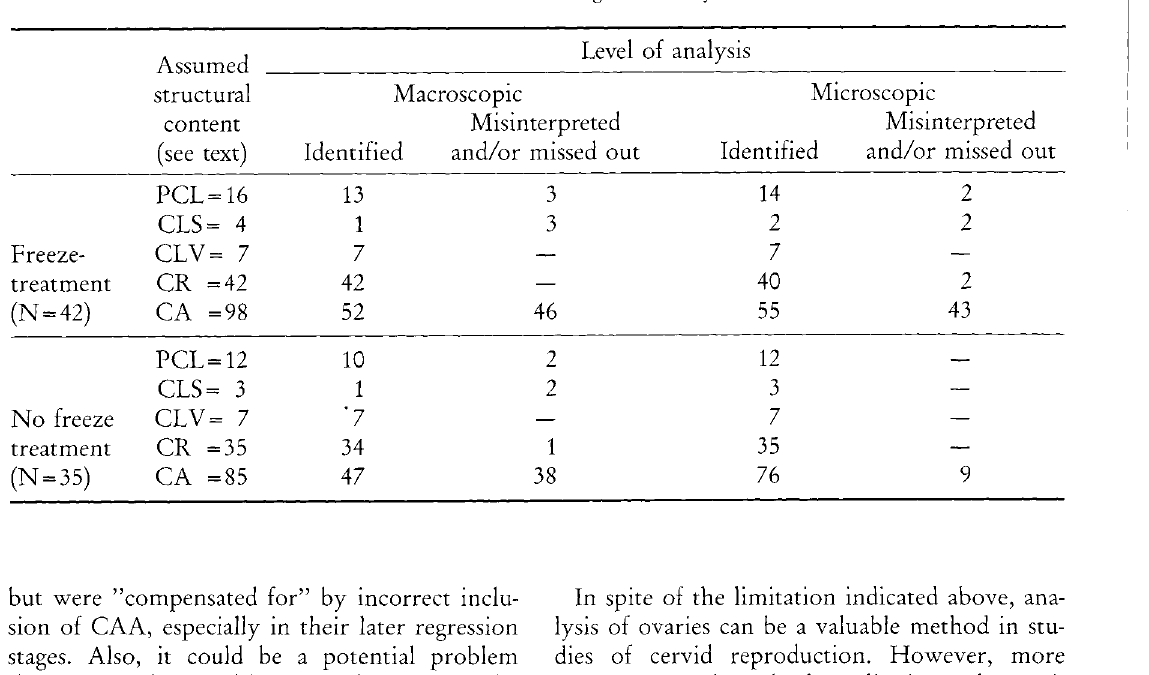
Tab. 6. The effect of freeze treatment of ovarian tissue with regard to analysis of structural